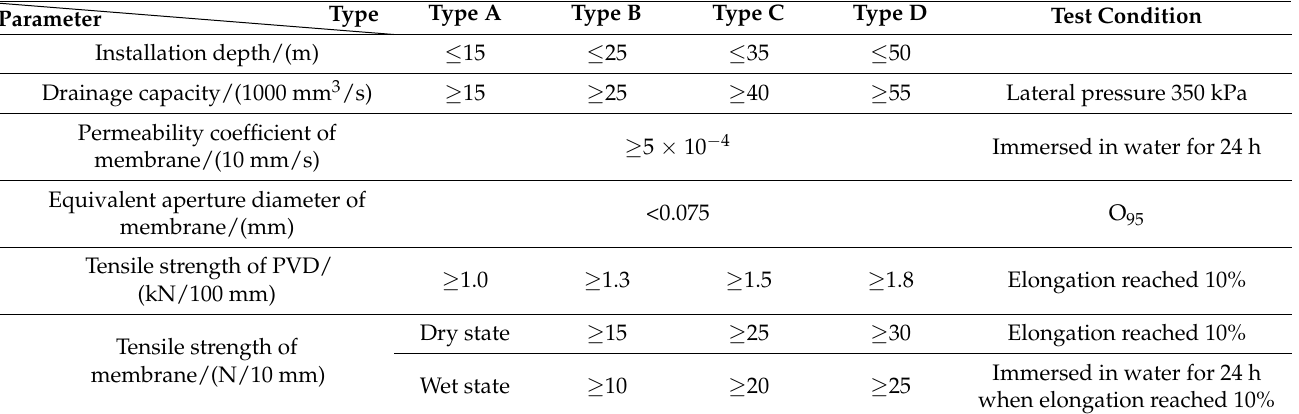
Table 3. Index properties of PVD.